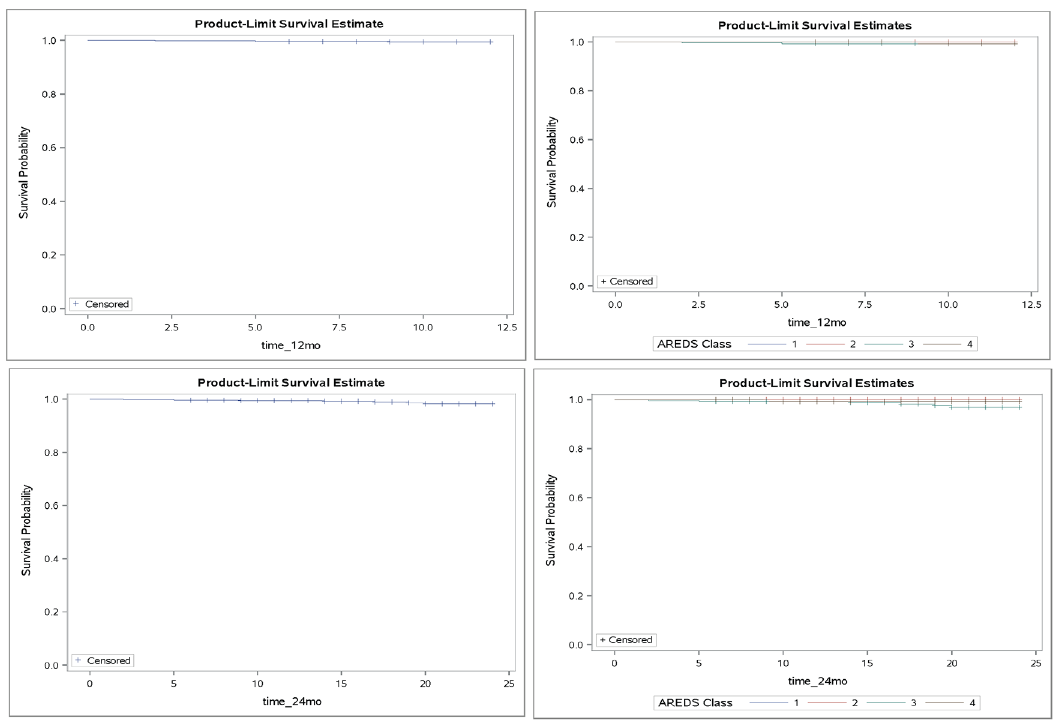
Fig 2. Kaplan-Meier plots showing the event probability across follow-up time overall (left) and by AREDS categories (right); for 12 months (top) and 24 months (bottom) of follow up. The steps down on the curve indicate the CNV cases, while the notches indicate censorship, when follow-up ended for